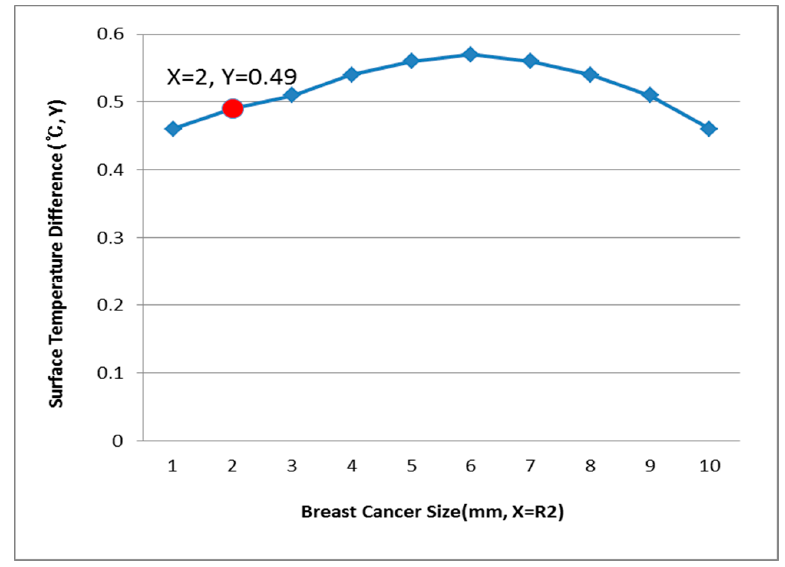
Figure 12. Surface temperature difference for an R1 of 60 mm (X = 10, Y = 10).